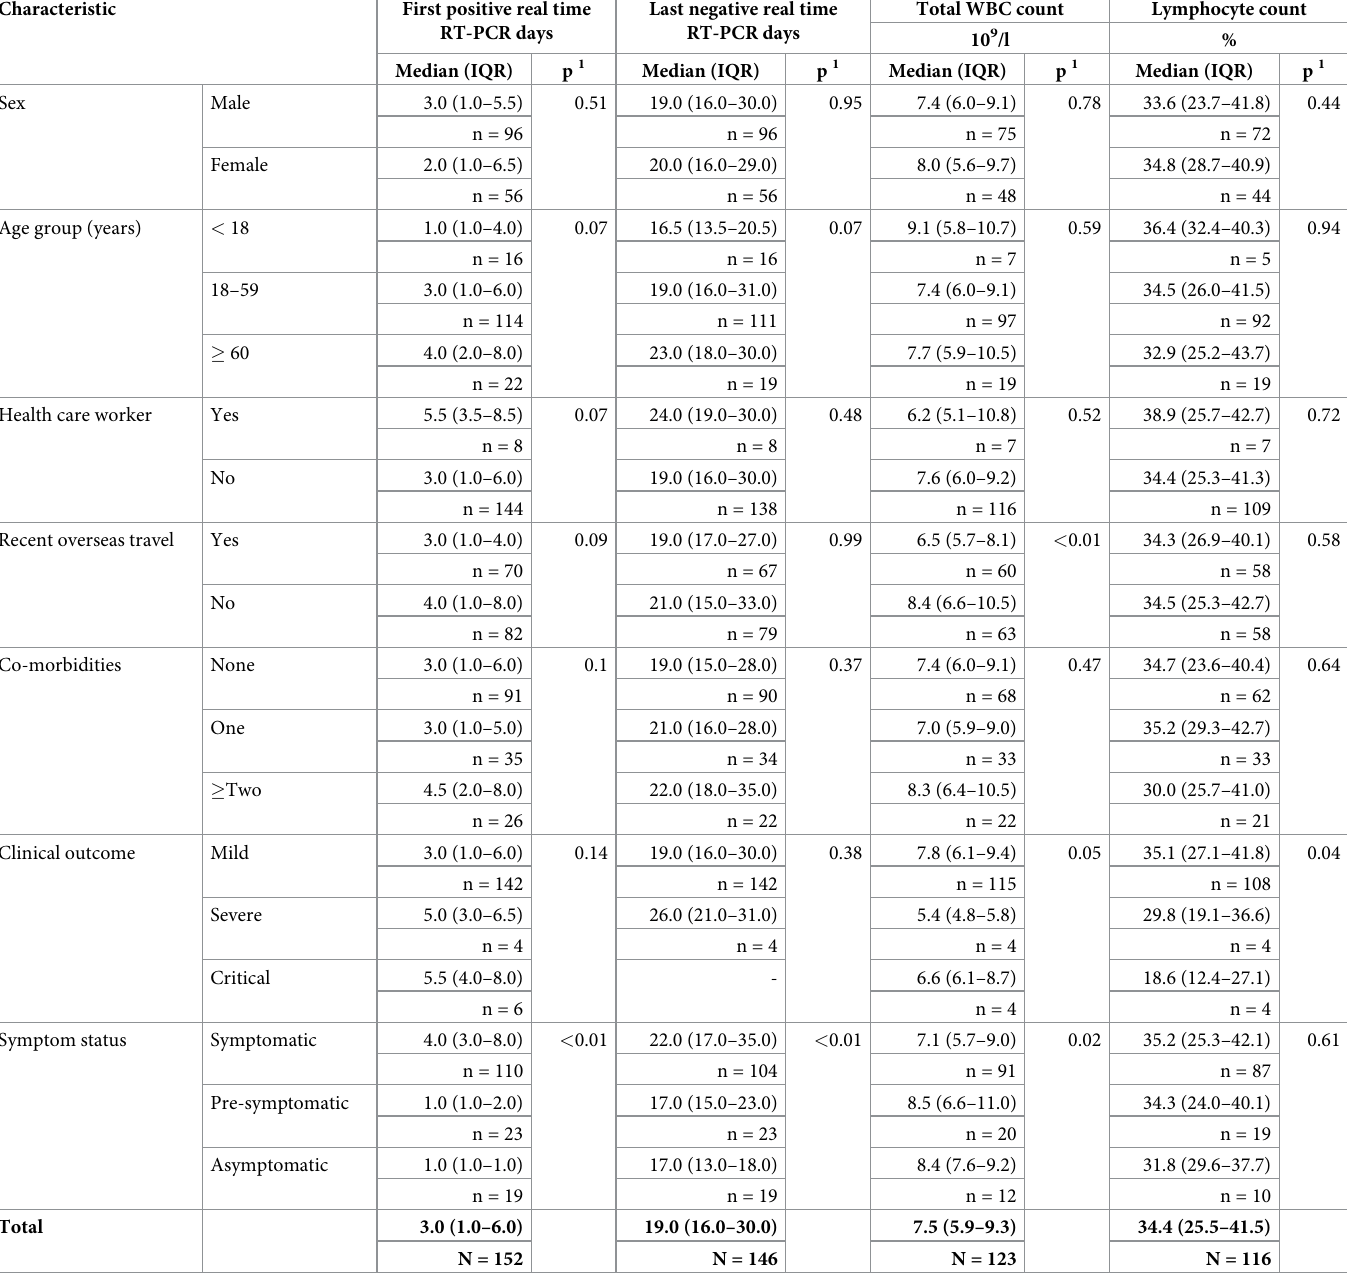
Table 3. Results of the laboratory investigations of the participants by patient and disease characteristics.